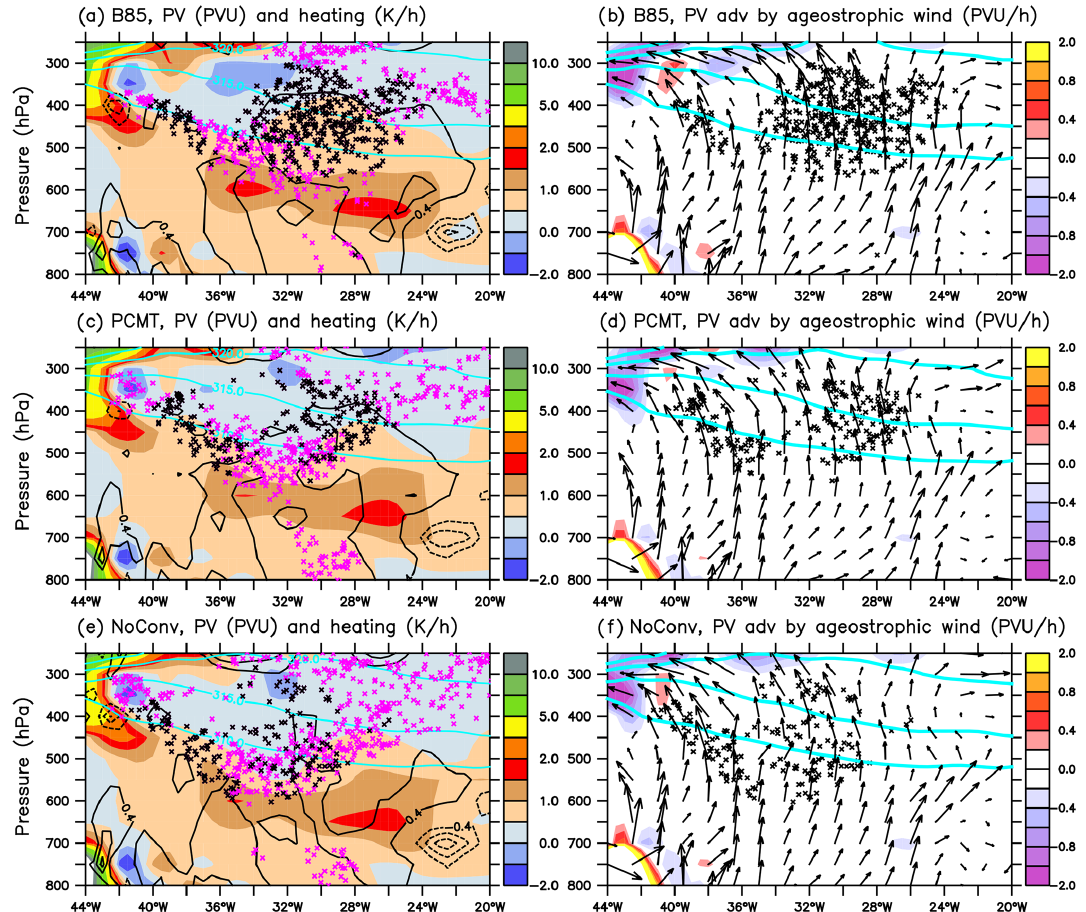
Figure 7. (a, c, e) Latitudinally averaged (63–65 ◦ N) PV (shadings; units: PVU), heating rate (black contours; interval: 0.4Kh − 1 ), potential temperature (light blue contours for 310, 315, 320 and 325K) and WCB trajectories satisfying 25hPa ascent in 2h (black crosses) and the other WCB trajectories (purple crosses) and located in the same latitudinal band at 12:00UTC on 2 October for (a) B85, (c) PCMT and (e) NoConv simulations. (b, d, f) Latitudinally averaged (63–65 ◦ N) PV advection by the zonal and vertical components of the ageostrophic wind (shadings; units: PVUh − 1 ), and the associated ageostrophic wind vectors (black arrows). The light blue contours represent potential temperature as in left panels. The ageostrophic wind vectors are represented by multiplying respectively the zonal and vertical components by the distances occupied by 1m in longitude and 1Pa in pressure on the